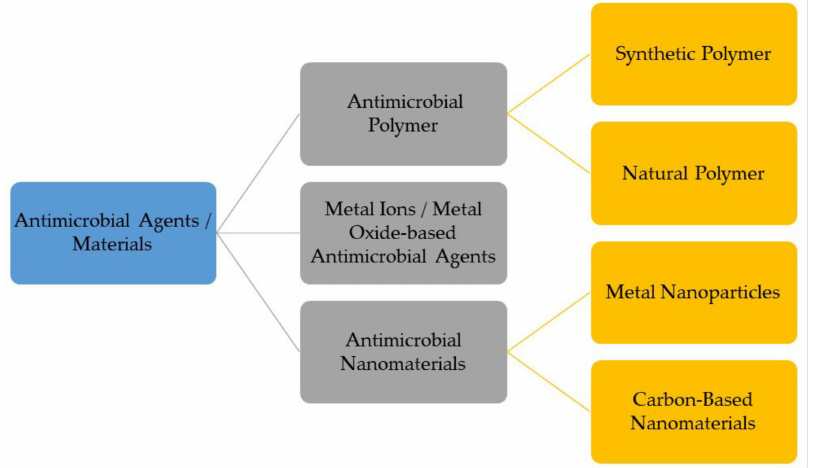
Figure 1. Classification of various antimicrobial agents/materials for development of antimicrobial surface